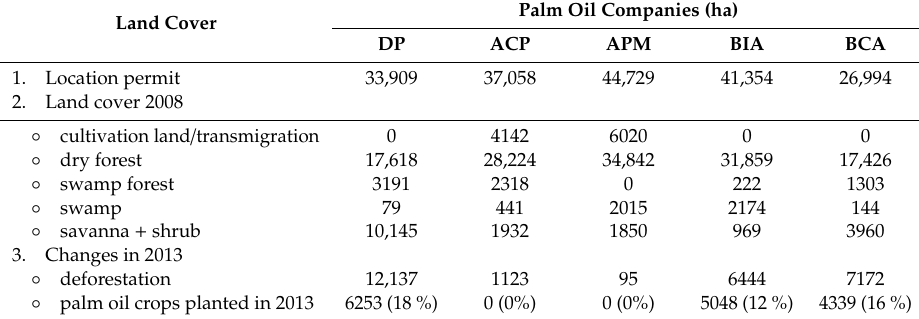
Table 2. Land cover changes for the five companies and the progress of plantation development. Palm Oil Companies (ha) Land Cover DP ACP APM